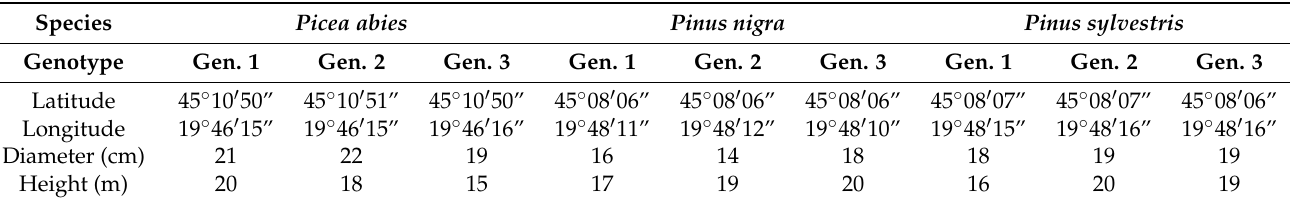
Table 2. Details of the investigated Pinus nigra , Pinus sylvestris and Picea abies genotypes.